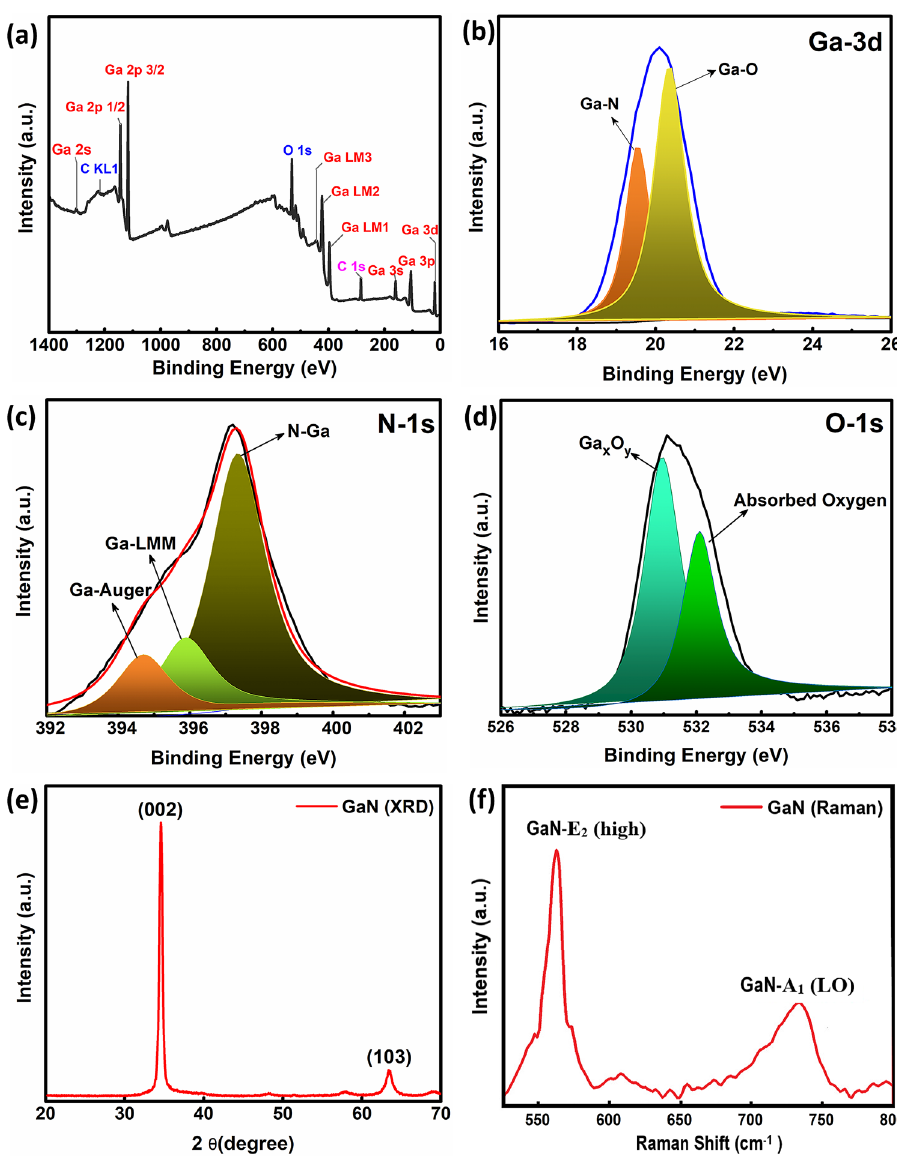
Figure 3. GaN sensing layer ( a ) Overall general scam spectrum, ( b ) Ga 3d band, ( c ) N 1s Band, and ( d ) O1s band, ( e ) XRD, and ( f ) Raman